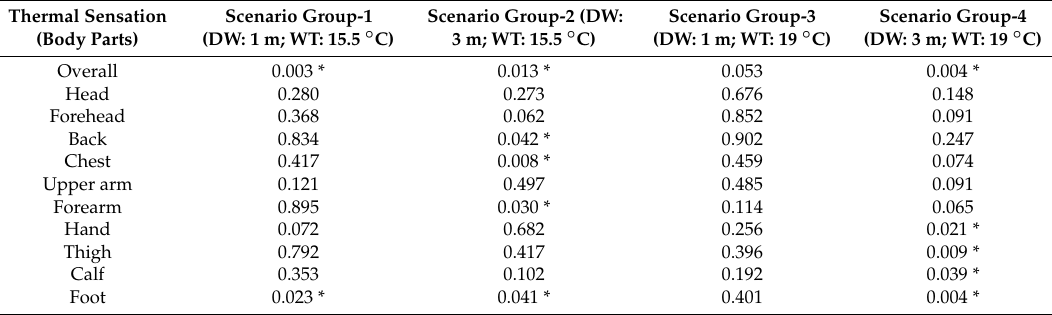
Table 4. Non-parametric Friedman ANOVA test. WT and DW stand for the window temperature and distance to the window, respectively.